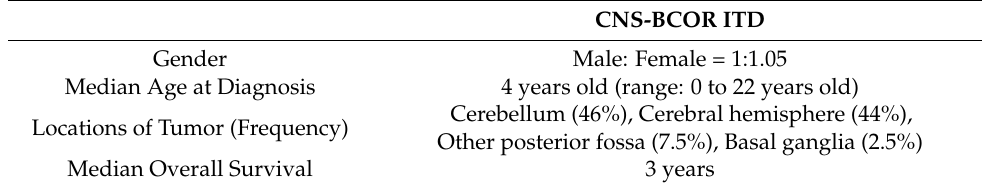
Table 1. Summary of molecularly confirmed cases of CNS-BCOR